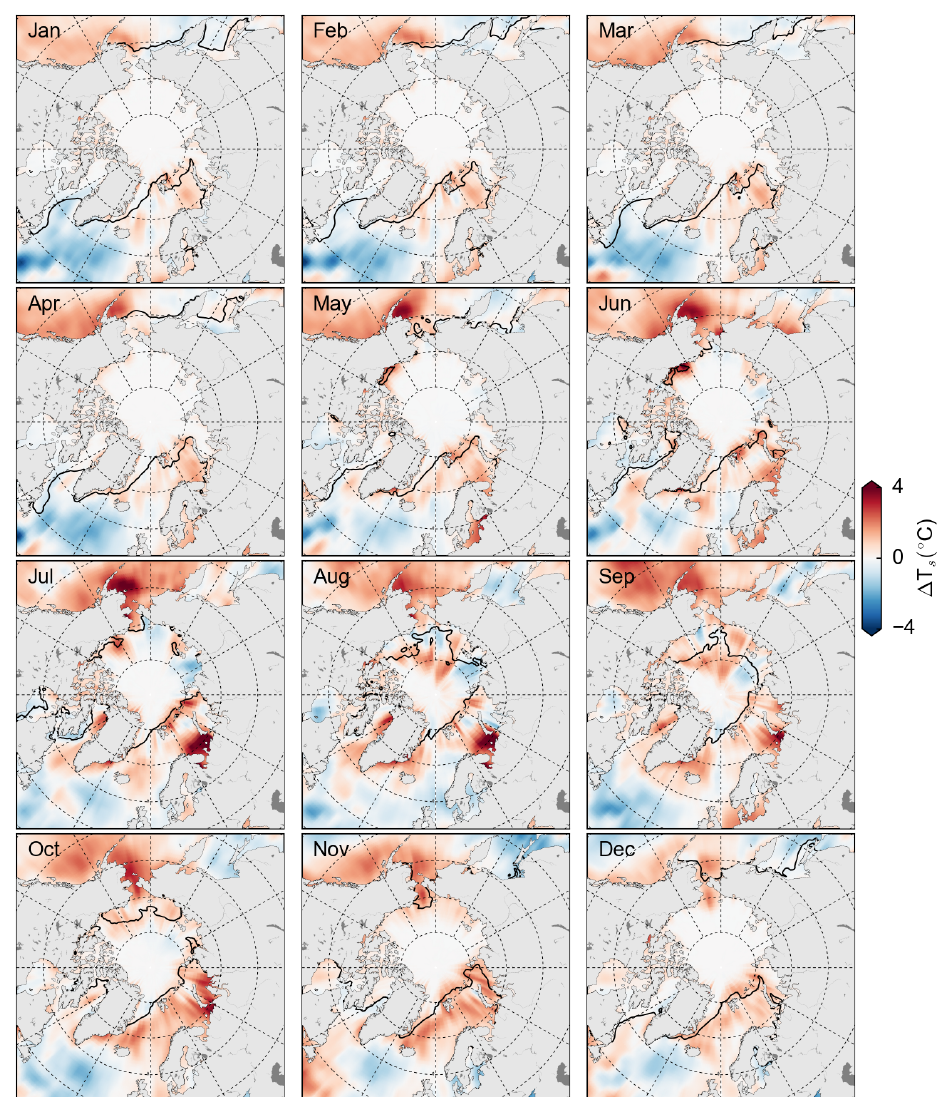
Figure 10. Monthly 2016 sea surface temperature (SST) anomalies (relative to the 2000–2015 mean) from NOAA’s OISST dataset. The black contour indicates the monthly 2016 sea ice edge (0.15 concentration